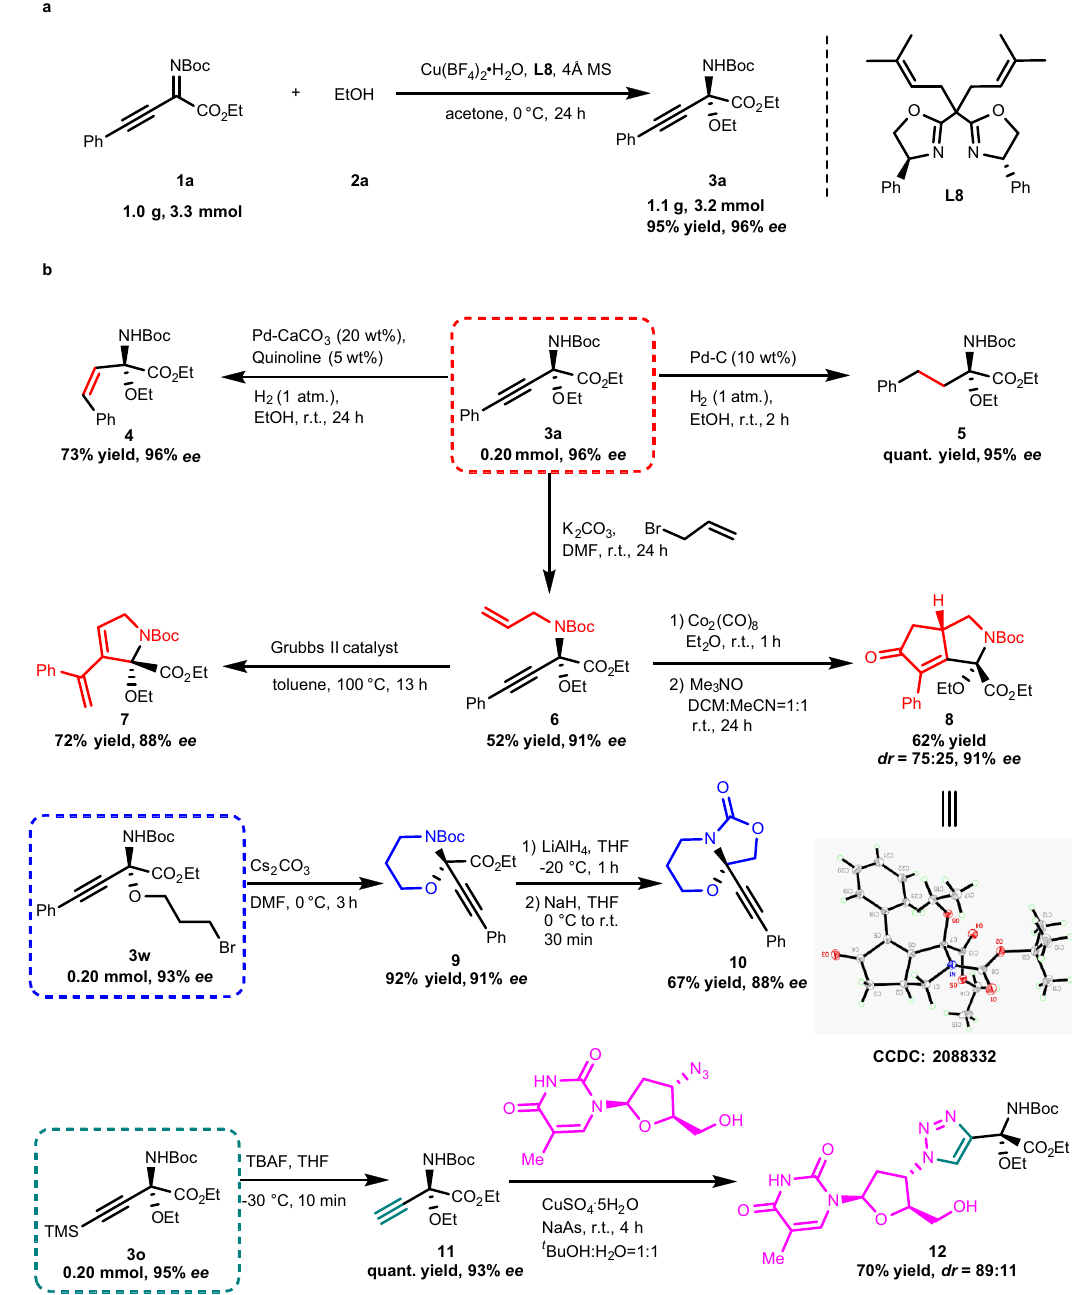
Fig. 6 Gram-scale synthesis and synthetic applications. a Gram-scale synthesis of 3a . b Transformation of linear chiral N , O